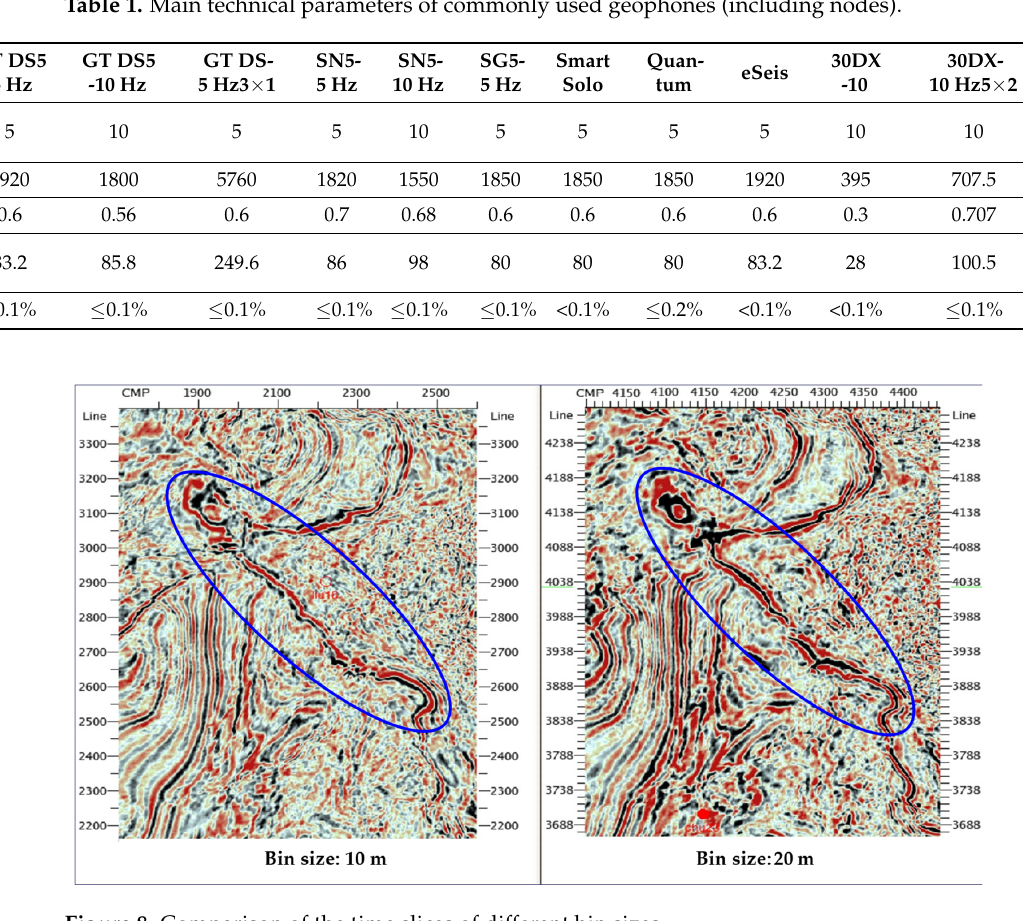
Figure 8. Comparison of the time slices of different bin sizes.